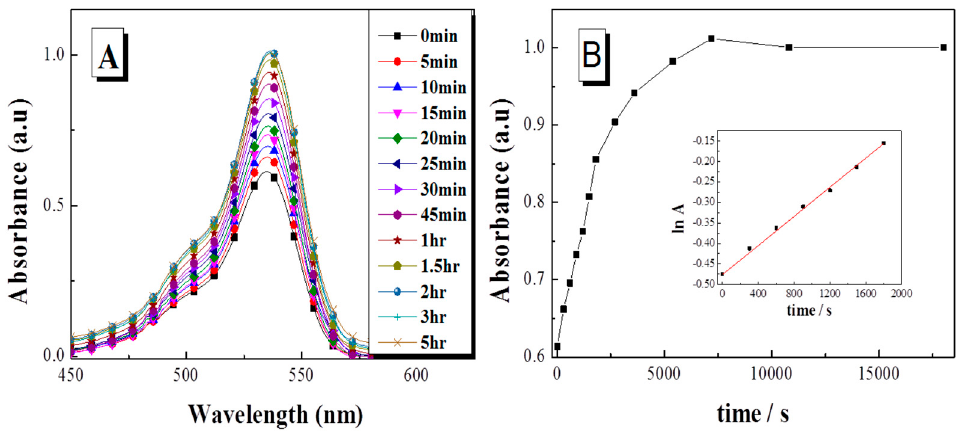
Figure 1. ( A ) The absorption peak of R-C/PLG–NCA mixtures ([R-C] = 5 × 10 − 3 M, [PLG–NCA] = 5 × 10 − 1 M in DMF) at 530 nm at various time after adding PLG–NCA; and ( B ) the variation of the resolved absorbance with time. Inset: The curves fitted with first-order reaction dynamics.